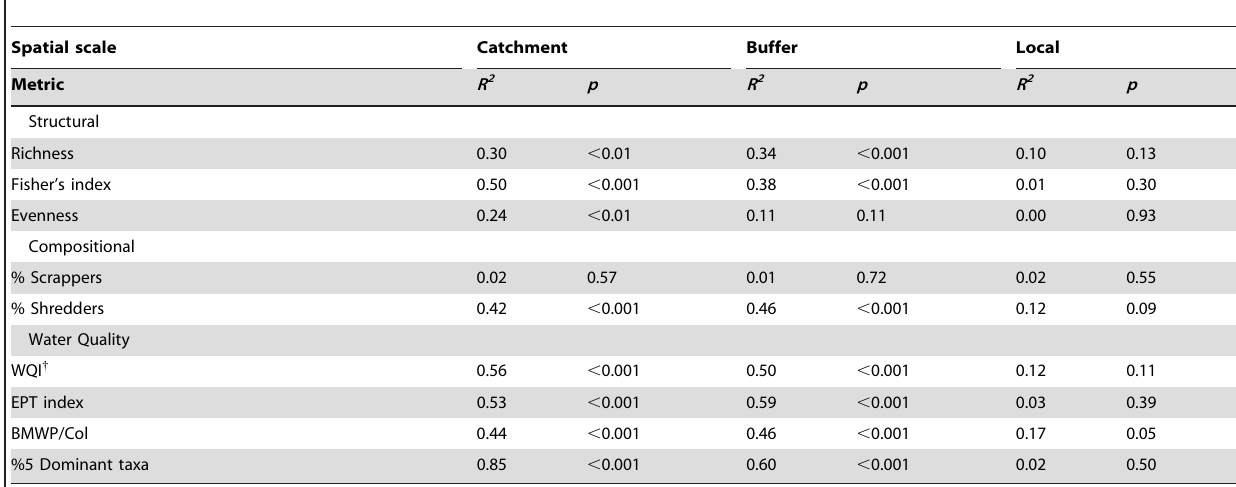
Table 2. Results of regression analysis between calculated macroinvertebrate metrics and percentage of vegetation cover at multiple spatial